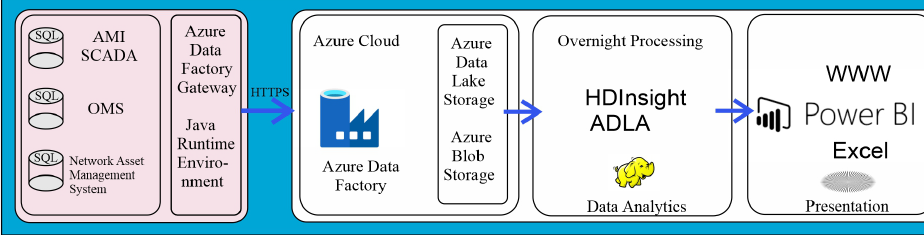
Figure 6. The general conception of the MDM Platform. Own study based on